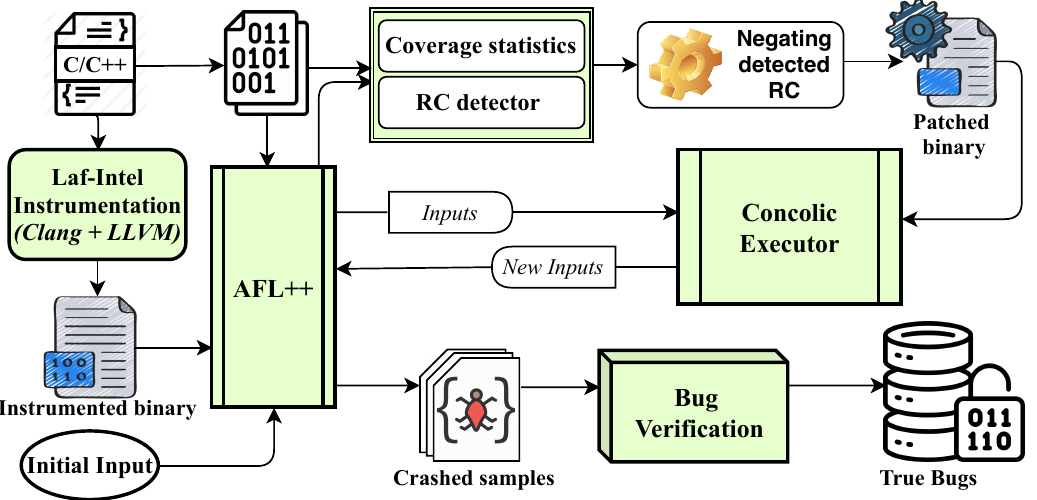
Figure 3. Overall workflow of the